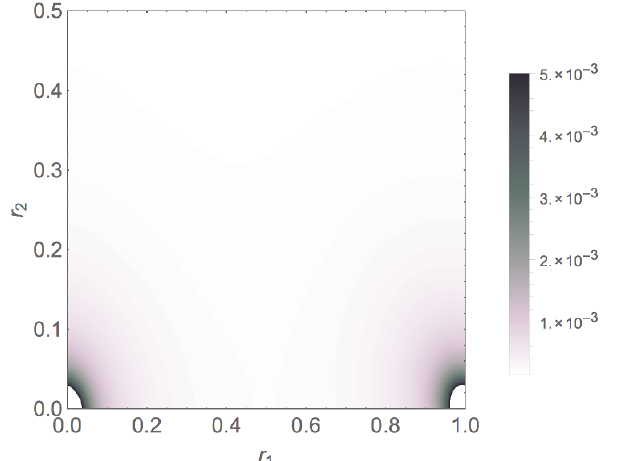
(Im z )2 (cid:12) (cid:12) (cid:0) z (cid:1) (cid:11) ! 2 (cid:10) V j (cid:28) e (cid:0) ( z; (cid:22) z ) V ! (0) 4 (cid:25)(cid:28) 2 (cid:12) (cid:18) 1 (cid:12) ! 2 (cid:25) Liouville ;T 2 ( (cid:28) ) 2 2